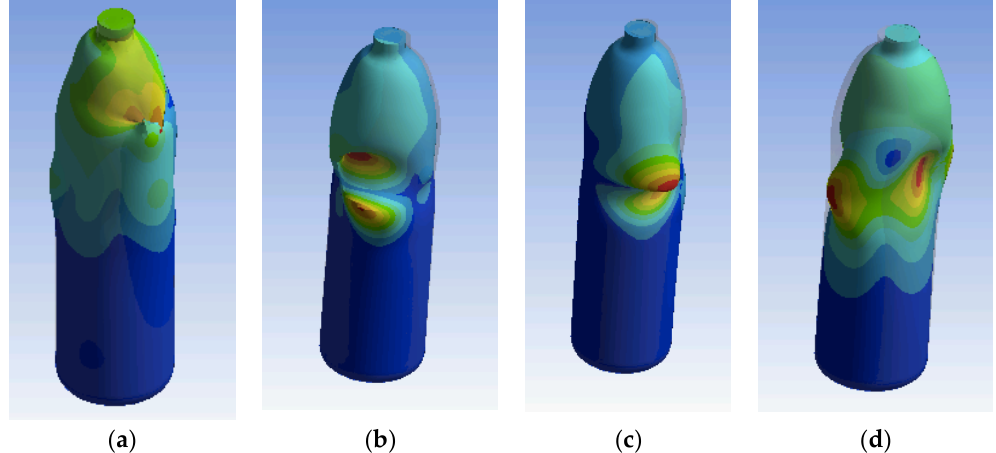
Figure 11. Buckling analysis in top-load conditions for a 10 mm vertical displacement, limited to the initial four modes of instability and for a load multiplier ( k ) of: ( a ) k = 0.19; ( b ) k = 0.16; ( c ) k = 0.12; ( d ) k = 0.09.